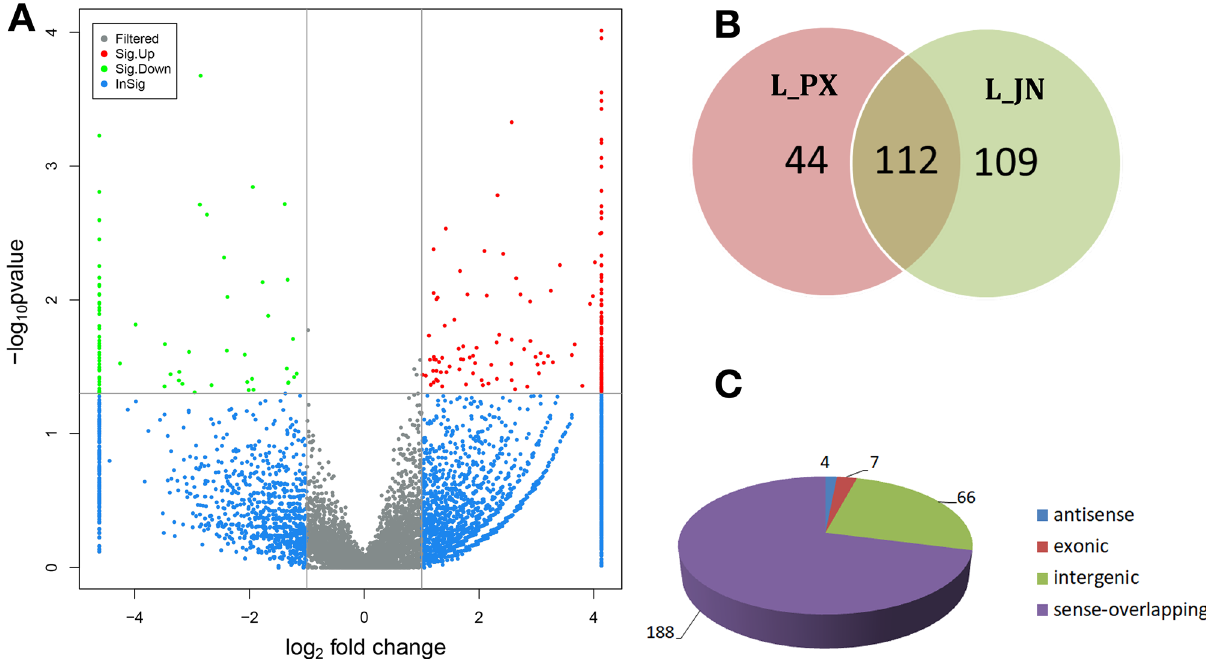
Figure 2. Overview of DEcircRNAs in the L_JN and L_PX. ( A ) Volcano plots showing the distribution of differentially expressed circRNAs between two adipose tissues. ( B ) Specific expression circRNA. ( C ) The proportion of various circRNAs in total